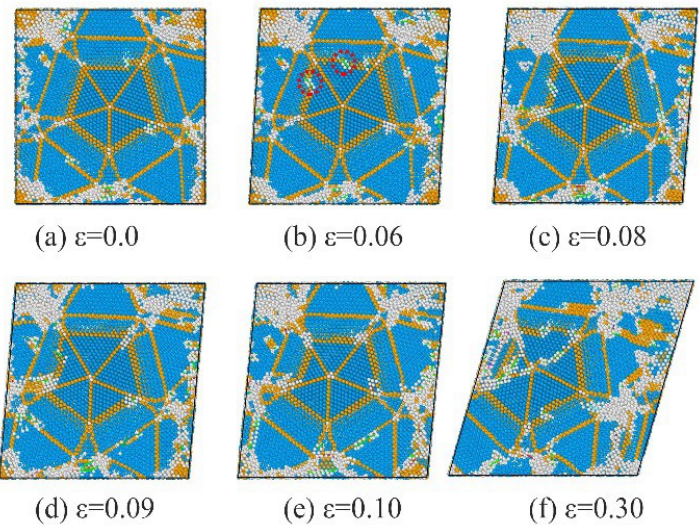
Figure 8. Slices of the evolutions of dislocations in the regular penta-twinned region. FCC structures are colored blue, and HCP structures are colored orange, other atoms are colored gray. ( a ) ε = 0.0, ( b ) ε =0.06, ( c ) ε = 0.08, ( d ) ε =0.09, ( e ) ε =0.10, ( f ) ε =0.30.